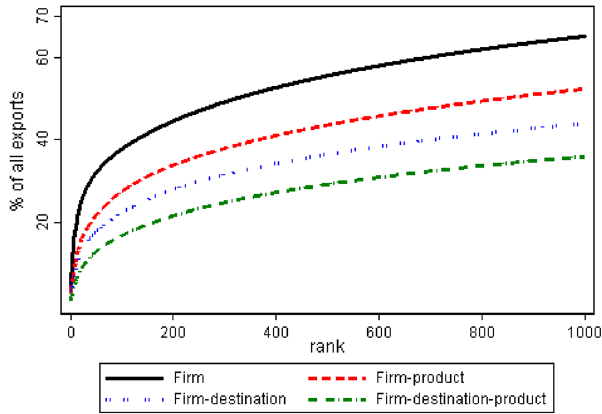
Fig. 4 Concentration of exports for different levels of aggregation, 1997. Source: Own calculations, based on the Customs